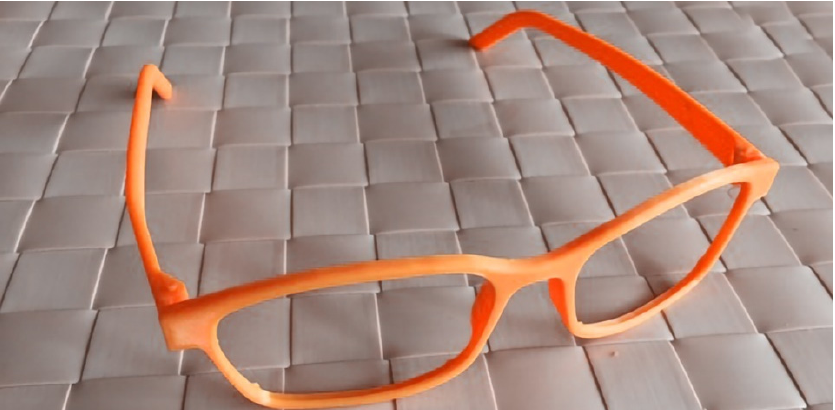
Figure 15. Result—3D-printed spectacles frames.